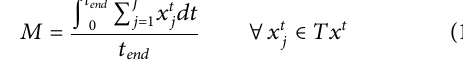
Frontiers in Robotics and AI |